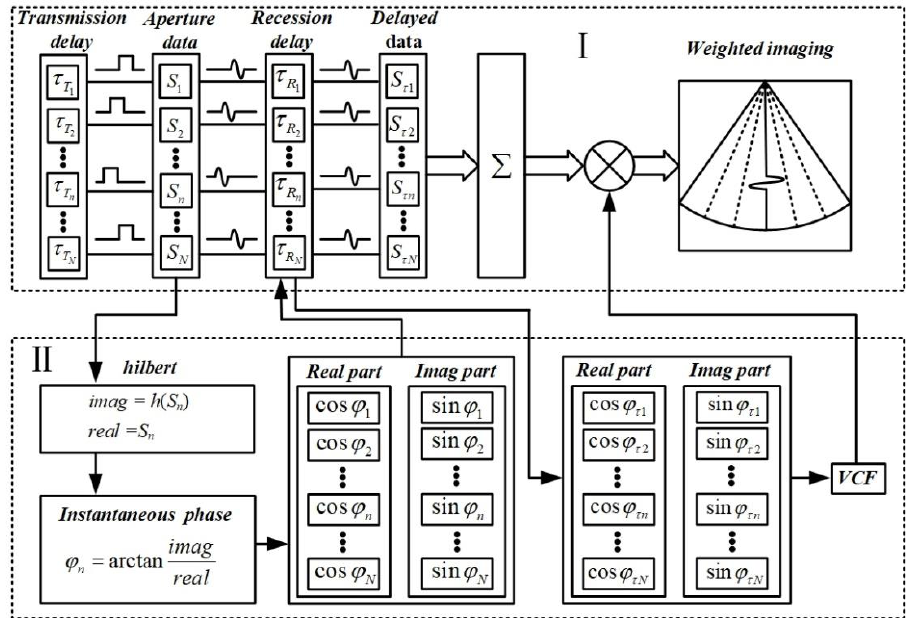
Figure 3. Flow chart of VCF weighted S−scan post -processing imaging principle.